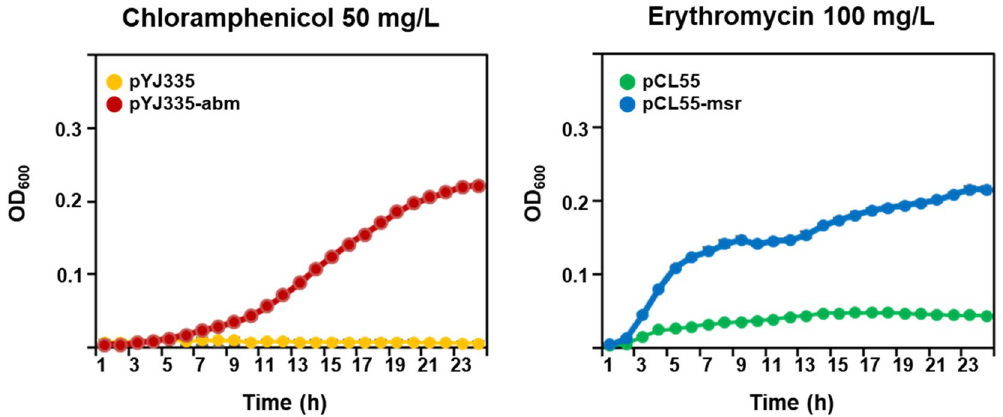
Figure 4. Effect of overexpression of S. equorum strain KM1031 genes abm and msr on resistance of Escherichia coli to chloramphenicol and erythromycin,